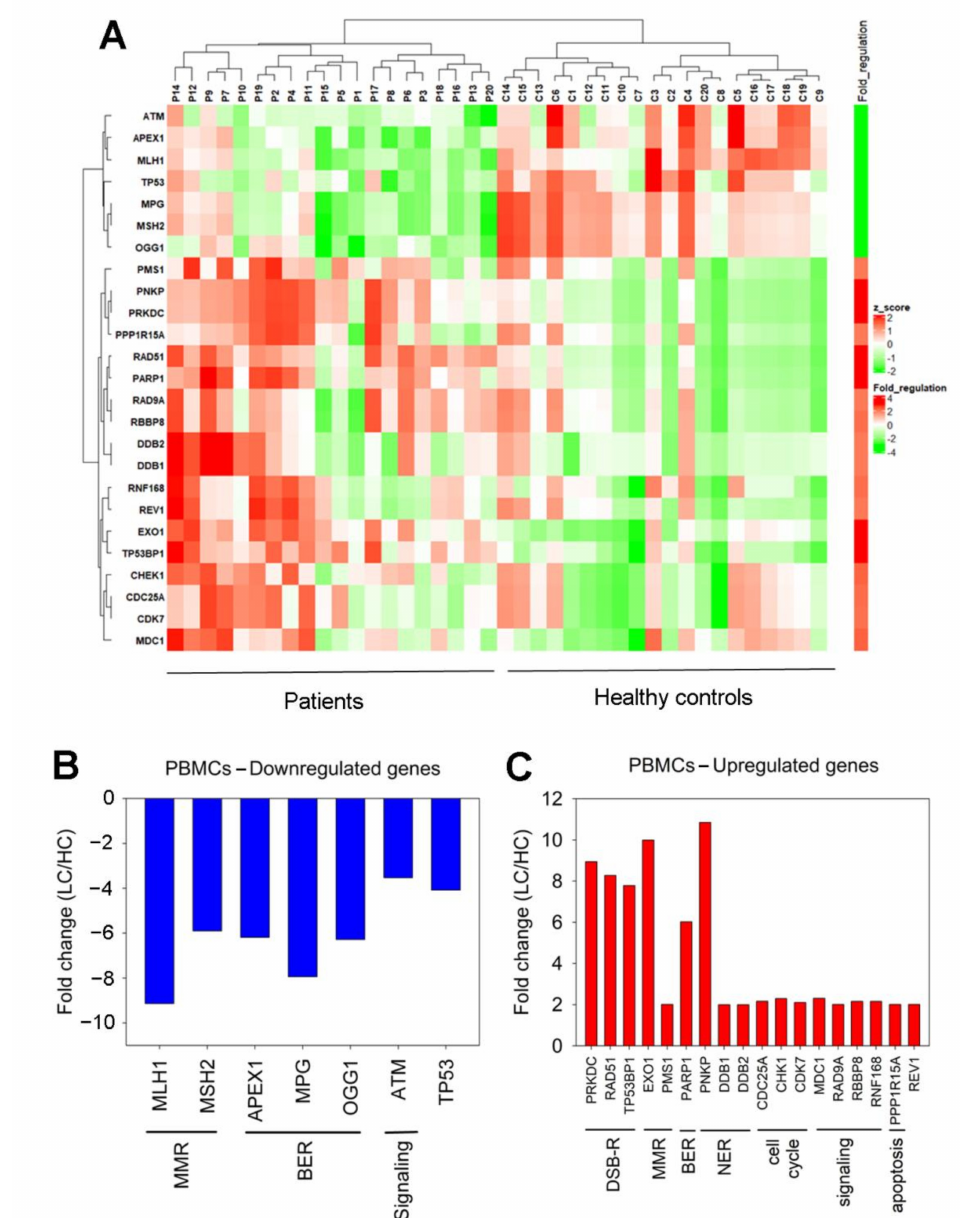
Figure 5. Differential gene expression of DDR-associated genes. ( A ) Heat map of 25 differentially expressed genes in PBMCs from 20 lung cancer patients at diagnosis versus 20 healthy controls. ( B , C ) Genes demonstrating at least a 2-fold difference in the transcription activity between lung cancer (LC) patients and healthy controls